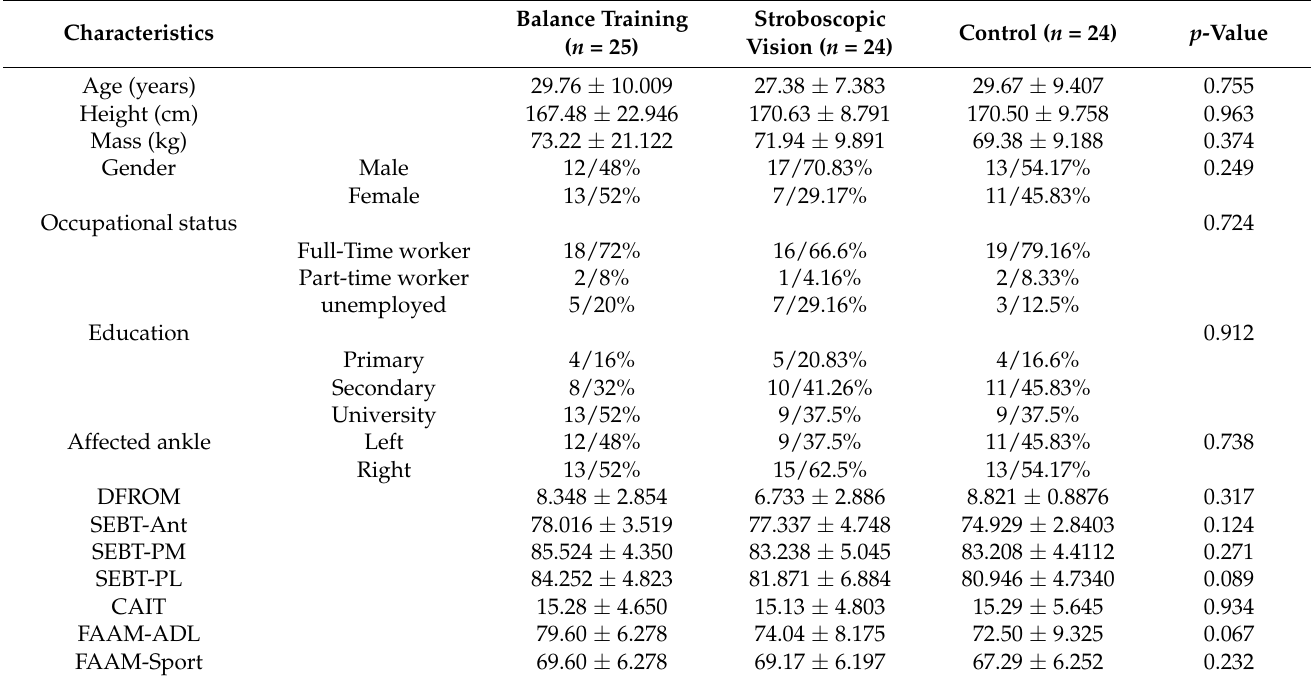
Table 1. Sociodemographic characteristics at